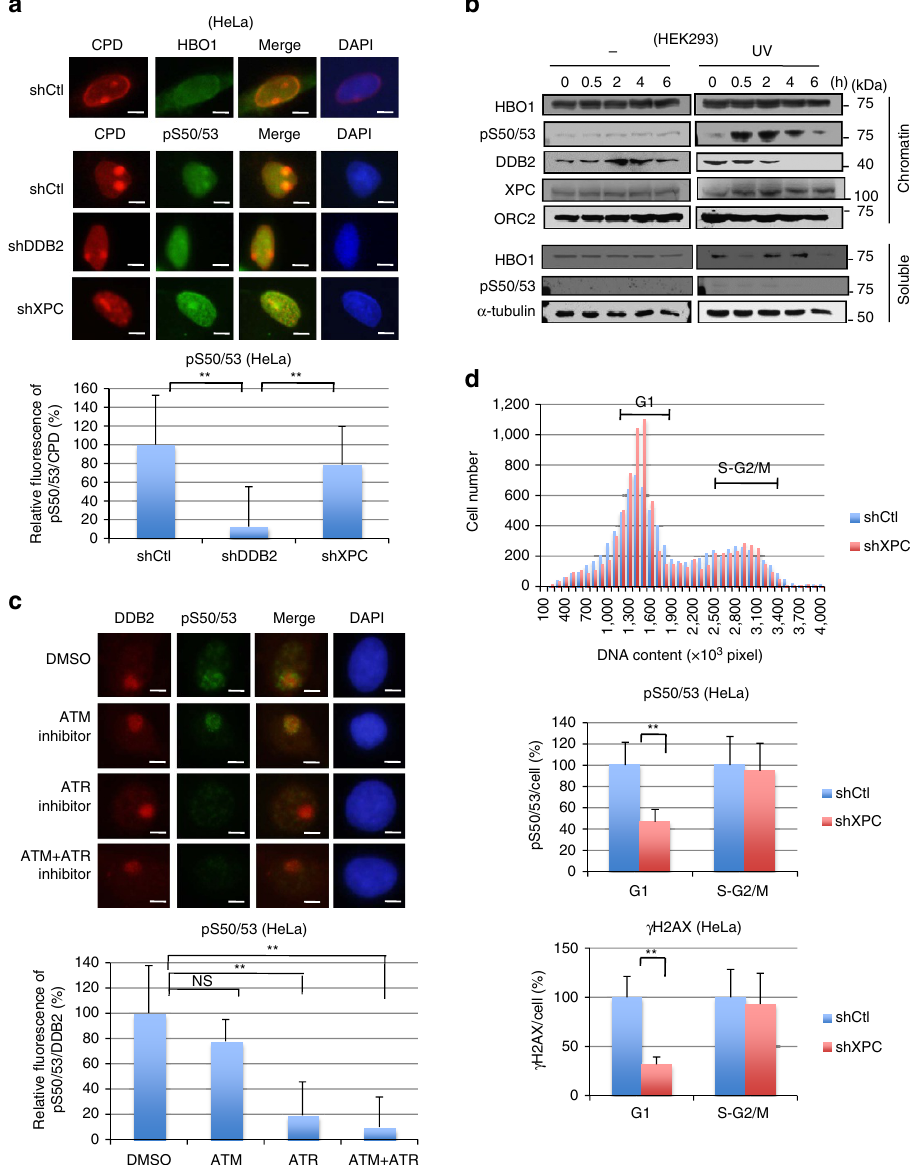
Figure 1 | Phosphorylated HBO1 is detected in ultraviolet-induced DNA damage sites. ( a ) Representative images of immunostaining for CPD and HBO1 or HBO1 pS50/53. HBO1 was phosphorylated at sites of local ultraviolet irradiation. shCtl, shDDB2 and shXPC cells were irradiated with 12Jm (cid:2) 2 ultraviolet through a membrane with 5- m m pores. Cells were cultured for 30min. Anti-HBO1 and anti-HBO1 pS50/53 antibodies were used for co-staining with anti-CPD antibody. The definition of relative fluorescence is shown in Supplementary Fig. 1b. The relative pS50/53/CPD intensities of shDDB2 and shXPC are shown as % of shCtl cells. Scale bars, 5 m m. n ¼ 30 cells from three independent experiments; error bars indicate means ± s.d. ** P o 0.01 (Student’s t -test). Scanned images were subjected to linear adjustments of light–dark and contrast by Microsoft Power Point. ( b ) HBO1 pS50/53 is detected on the chromatin until 2h after ultraviolet irradiation. HEK293 cells were mock-treated or irradiated with 50Jm (cid:2) 2 ultraviolet. Cell lysates were fractionated into soluble and chromatin- enriched samples and then subjected to western blotting with the indicated antibodies. Scanned images were subjected to linear adjustments of lighta˜dark and contrast by Microsoft Power Point. ( c ) Inhibition of ATR reduced accumulation of HBO1 pS50/53 at the damage sites. Cells were incubated with ATM and/or ATR inhibitors for 2h before local ultraviolet irradiation at 50Jm (cid:2) 2 . After 30min, cells were fixed and immunostained with anti-DDB2 and anti-HBO1 pS50/ 53 antibodies. The relative pS50/53/DDB2 intensities of ATM and/or ATR inhibitor-treated cells are shown as % of DMSO control cells. Scale bars, 5 m m. n ¼ 50 cells from three independent experiments; error bars indicate means ± s.d. ** P o 0.01 (Student’s t -test). ( d ) Phosphorylation of HBO1 Ser50 and Ser53 in G1 phase is dependent on XPC. Cells were irradiated 50Jm (cid:2) 2 ultraviolet and cultured for 30min. Cells were fixed and immunostained with anti-pS50/53 and anti- g H2AX antibodies. DNA was stained with DAPI. DNA contents and fluorescence intensities of pS50/53 or g H2AX in cells were quantified by the IN Cell Analyzer. Cells in G1 or S-G2/M phase were defined by DNA content. The average pS50/53 or g H2AX intensity in shXPC cells in G1 and S-G2/M phase is shown as % of shCtl cells. Cells ( n ¼ 1,500) from three independent experiments; error bars indicate means ± s.d. ** P o 0.01 (Student’s t